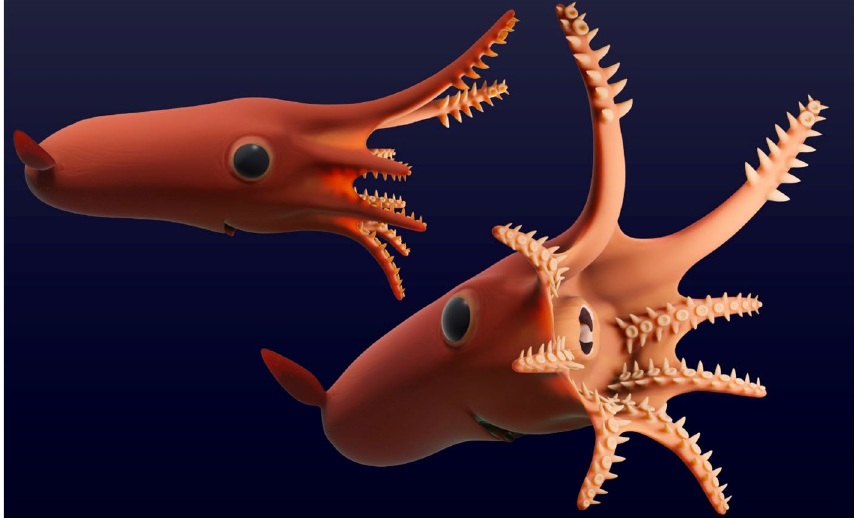
Figure 4. Hypothesised reconstruction of V. rhodanica based on the data from this study (A. Lethiers, CR2P). The scale is based on measurements from the holotype (MNHN.B.74247) and the arm crown is completed using dimensions from